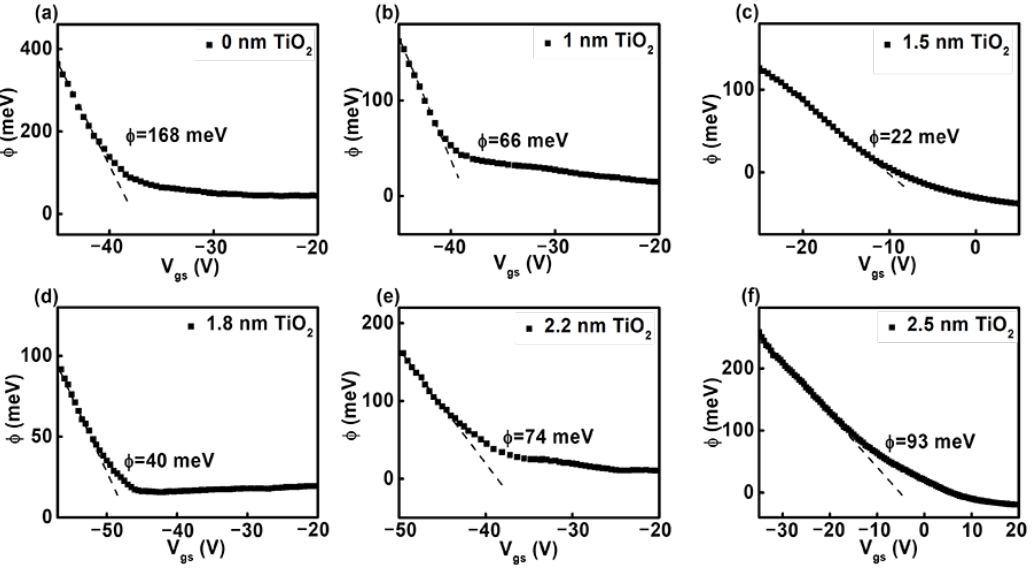
Figure 5. ( a – f ) Effective Schottky barrier heights as a function of gate overdrive for various TiO 2